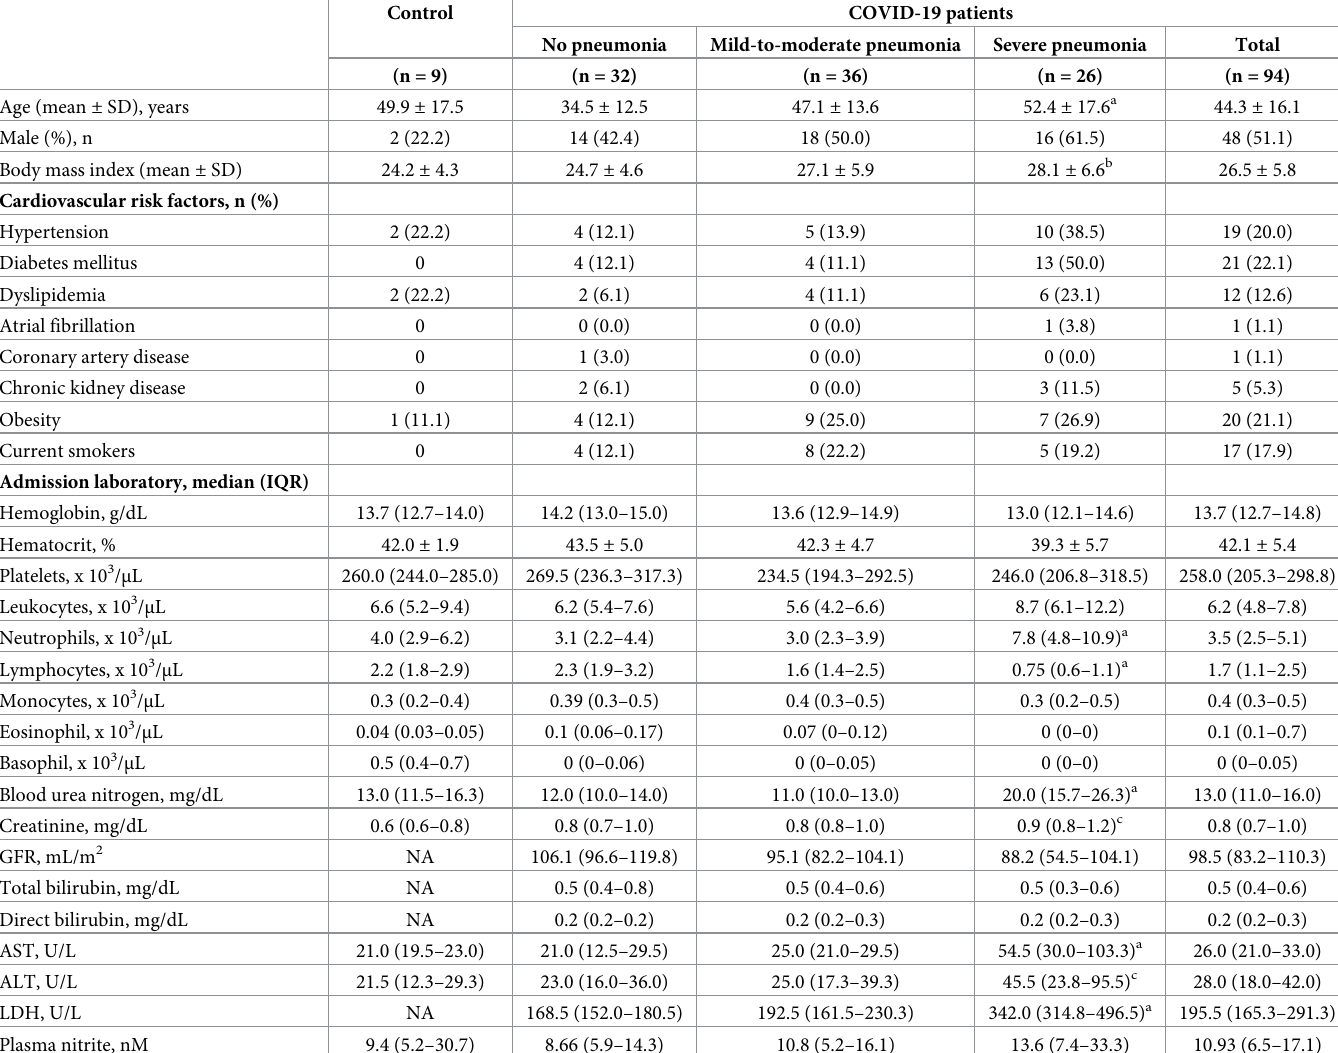
Table 1. Clinical parameters of control and COVID-19 patients on the admission day.